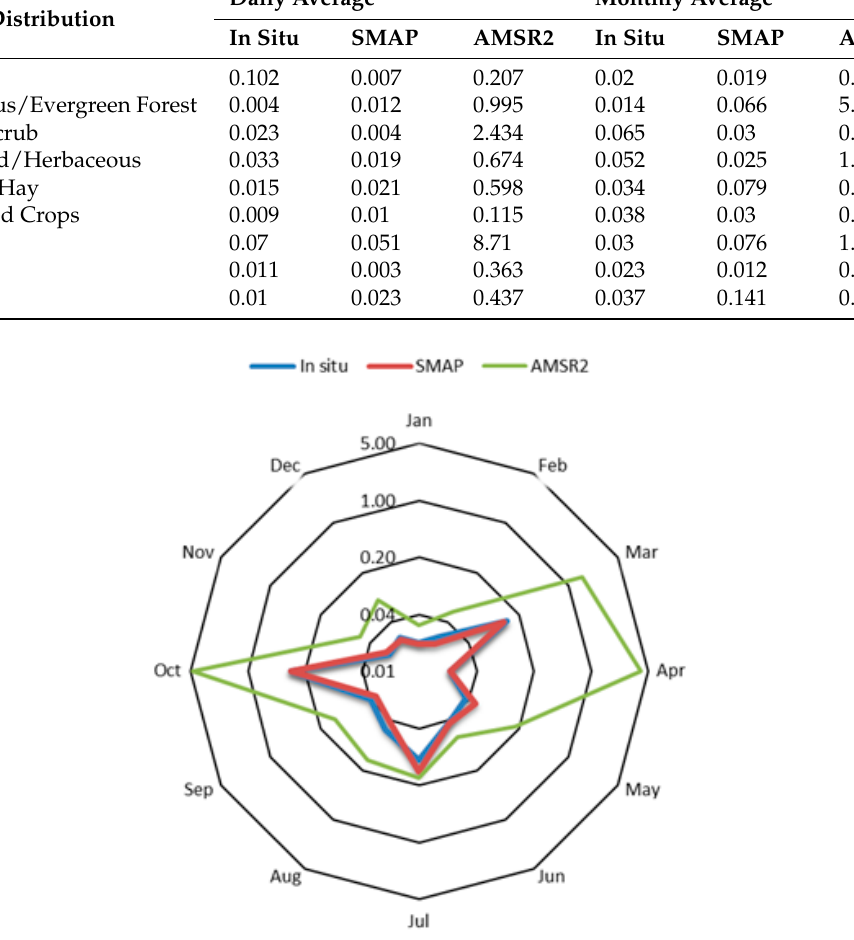
Figure 12. Estimated errors of soil moisture dataset for monthly average with the TC method. Table 3. Estimated errors of the in situ, SMAP, AMSR2 soil moisture dataset for different spatial distribute with the triple collocation (TC) method.